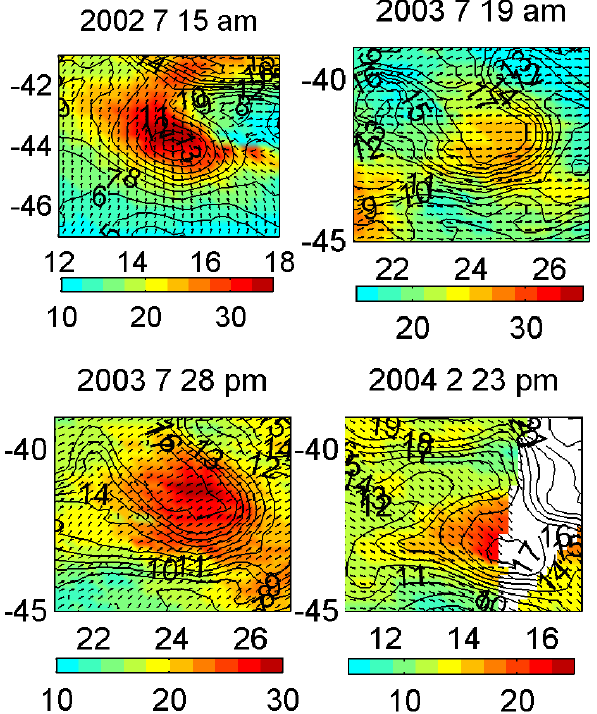
Figure 3. Clockwise from top left, instantaneous estimate of QuikScat wind speed in ms − 1 (colour) and directions (arrows) and AMSR microwave sea surface temperature in ◦ C (contours) south of the Agulhas Current system in the “Roaring forties” on the 15 July 2002 (morning path), 19 July 2003 (morning path), 23 Febru- ary 2004 (evening path) and 28 July 2003 (evening path), showing strong and homogeneous increases and decreases in wind speed col- located with increases and decrease of sea surface